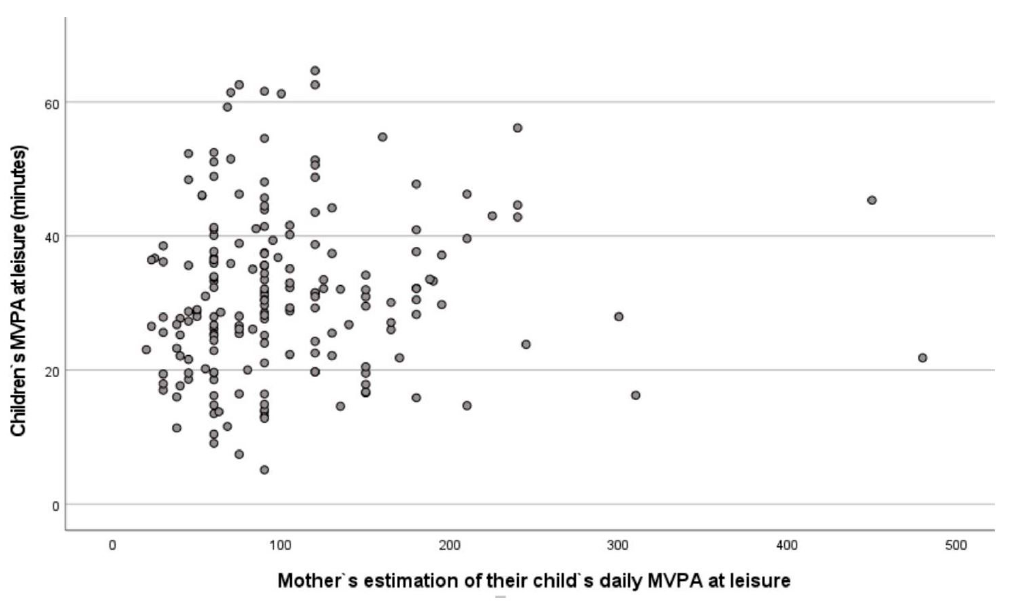
Figure 1. Scatter plot of preschool children’s MVPA at leisure time and mothers’ estimation of their children’s PA level.